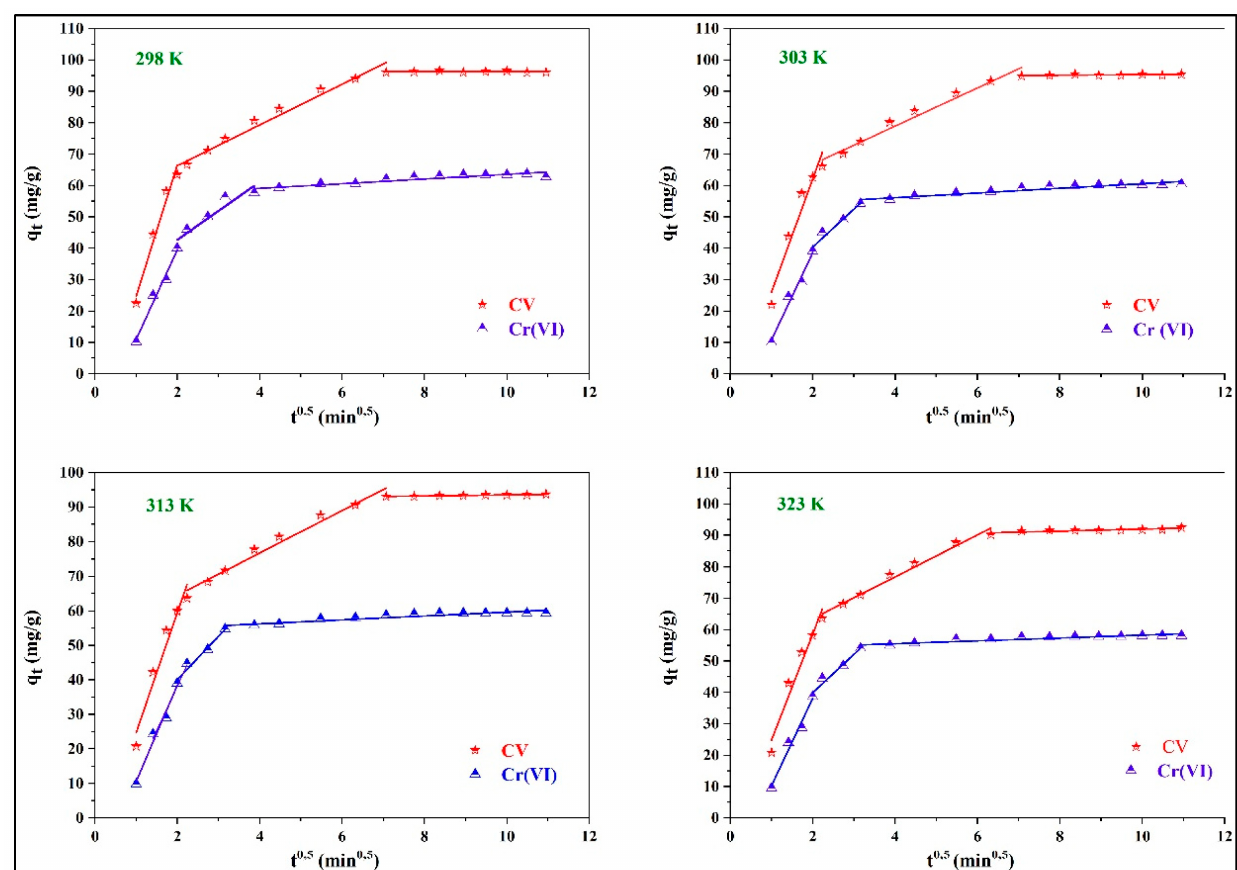
Figure 12. Intraparticle diffusion model plots for different